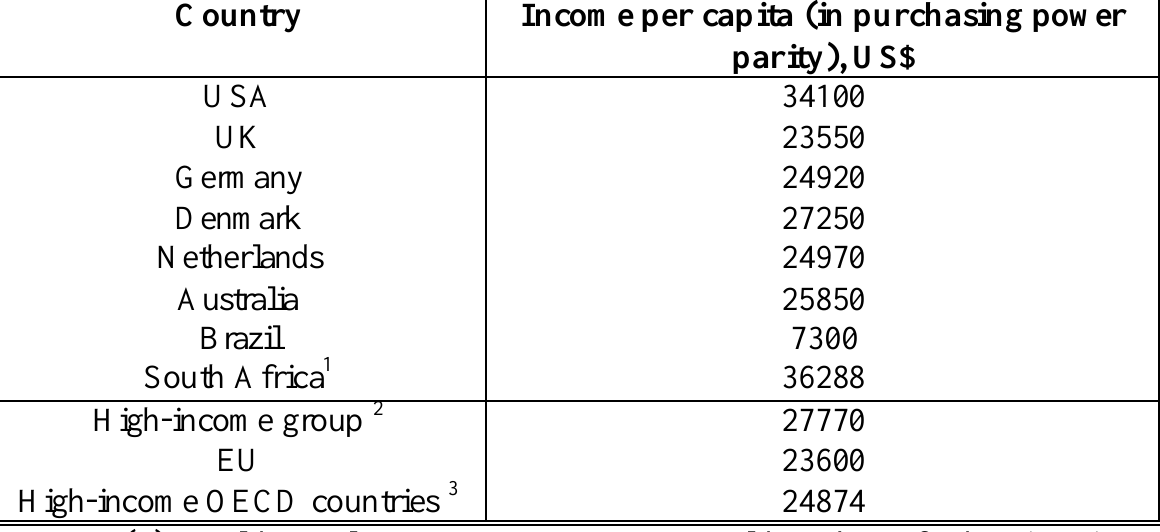
Estimated income per capita for the private sector, 2000 Country Income per capita (in purchasing power parity),